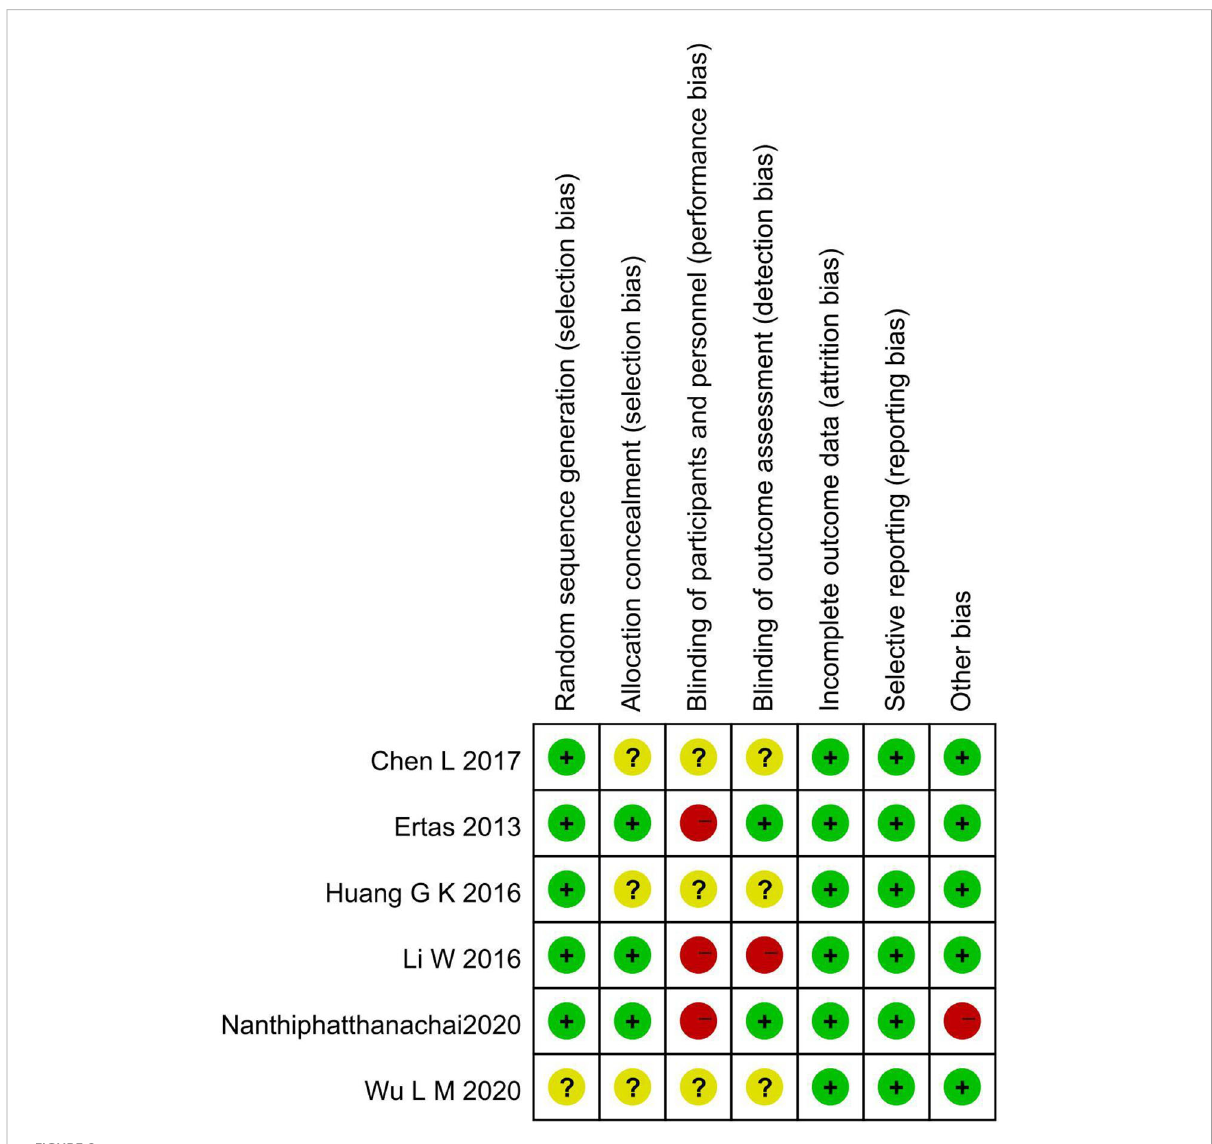
FIGURE 2 Methodological quality and risk of included